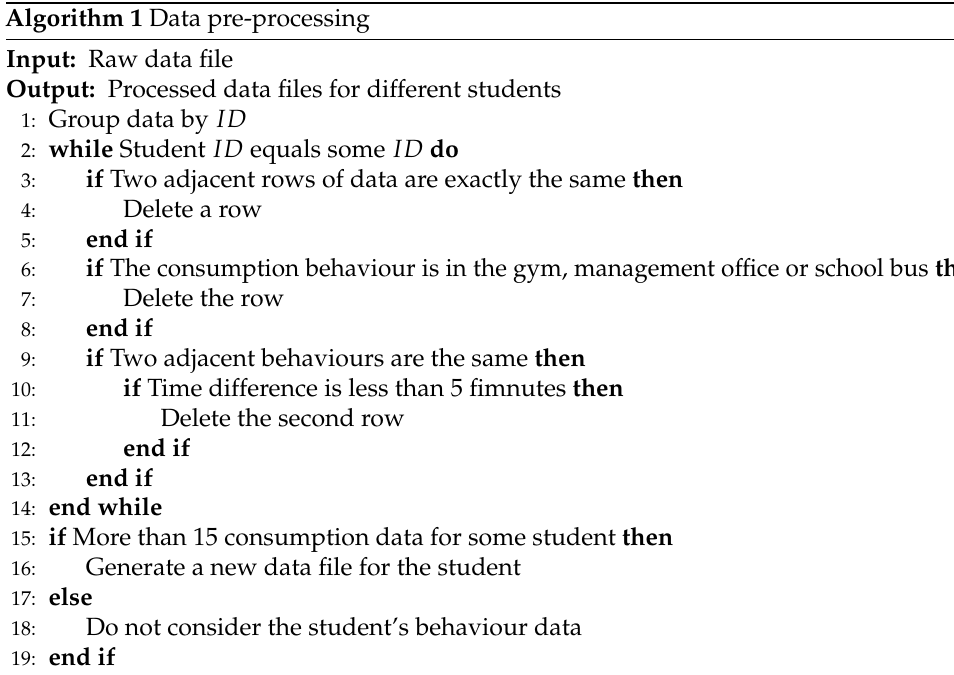
Algorithm 1 Data